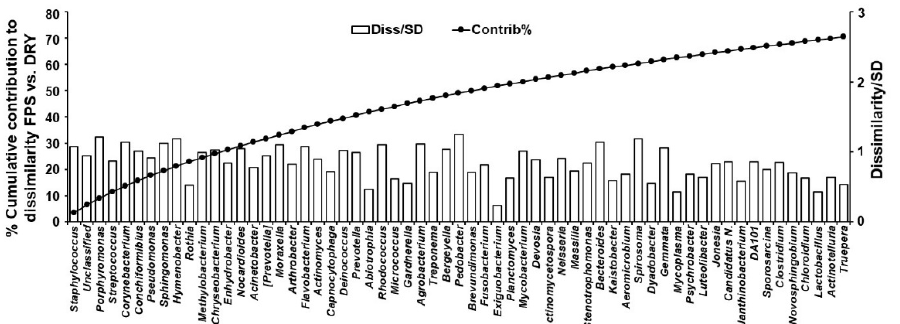
Figure 3. Cumulative genera percent dissimilarity of skin microbiome of pet dogs fed fresh (FPS) vs. dry (DRY) food. Cumulative % contribution of genera to dissimilarity between FPS and DRY (left Y axis), and their corresponding ratio of average dissimilarity to its standard deviation (right X axis).